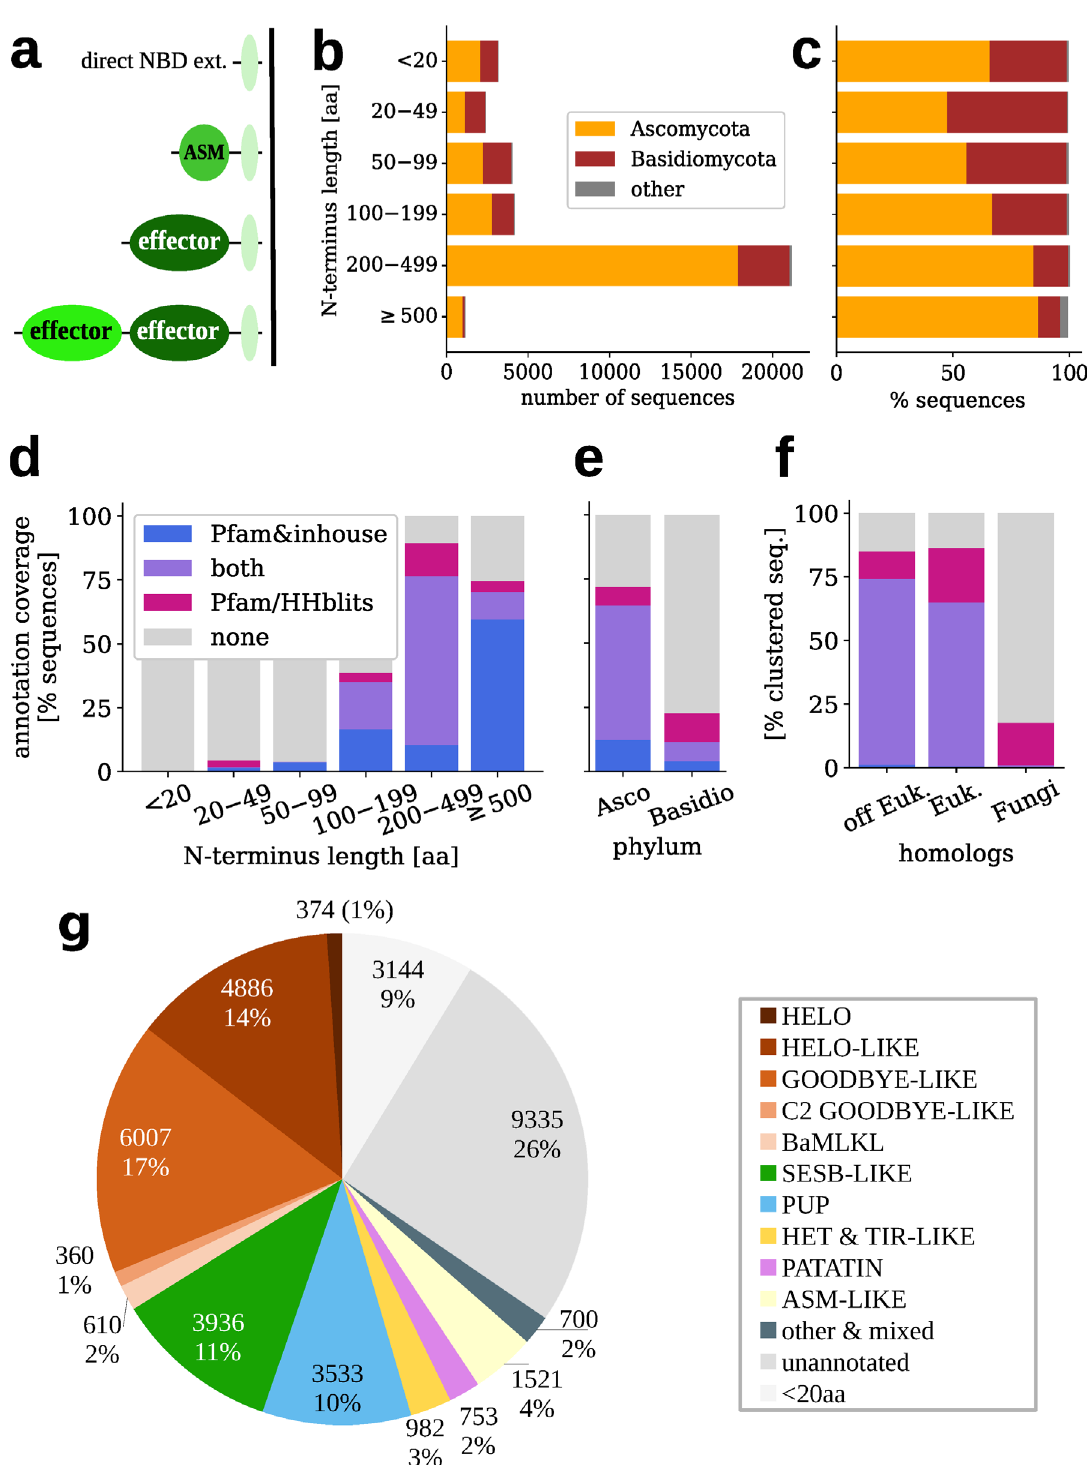
Fig 1. Fungal NLR N-termini. a ) Major general architectures; b ) N-termini length distribution with taxonomic division, c ) Same data scaled to 100% for each length range; Annotation coverage with regard to d ) N-terminus length, e ) taxonomic division; f ) Annotation coverage of the MMSeqs clustered N-termini with regard to presence of taxonomically distant homologs in UniRef top hits (see Results). Euk. denotes Eukaryota , off Euk. category includes Bacteria , Archaea and Viruses . Colored bars indicate fraction of Pfam & inhouse annotated sequences (blue: only direct Pfam hits, violet: direct and with clustering & HHblits, rose: only with clustering & HHblits).